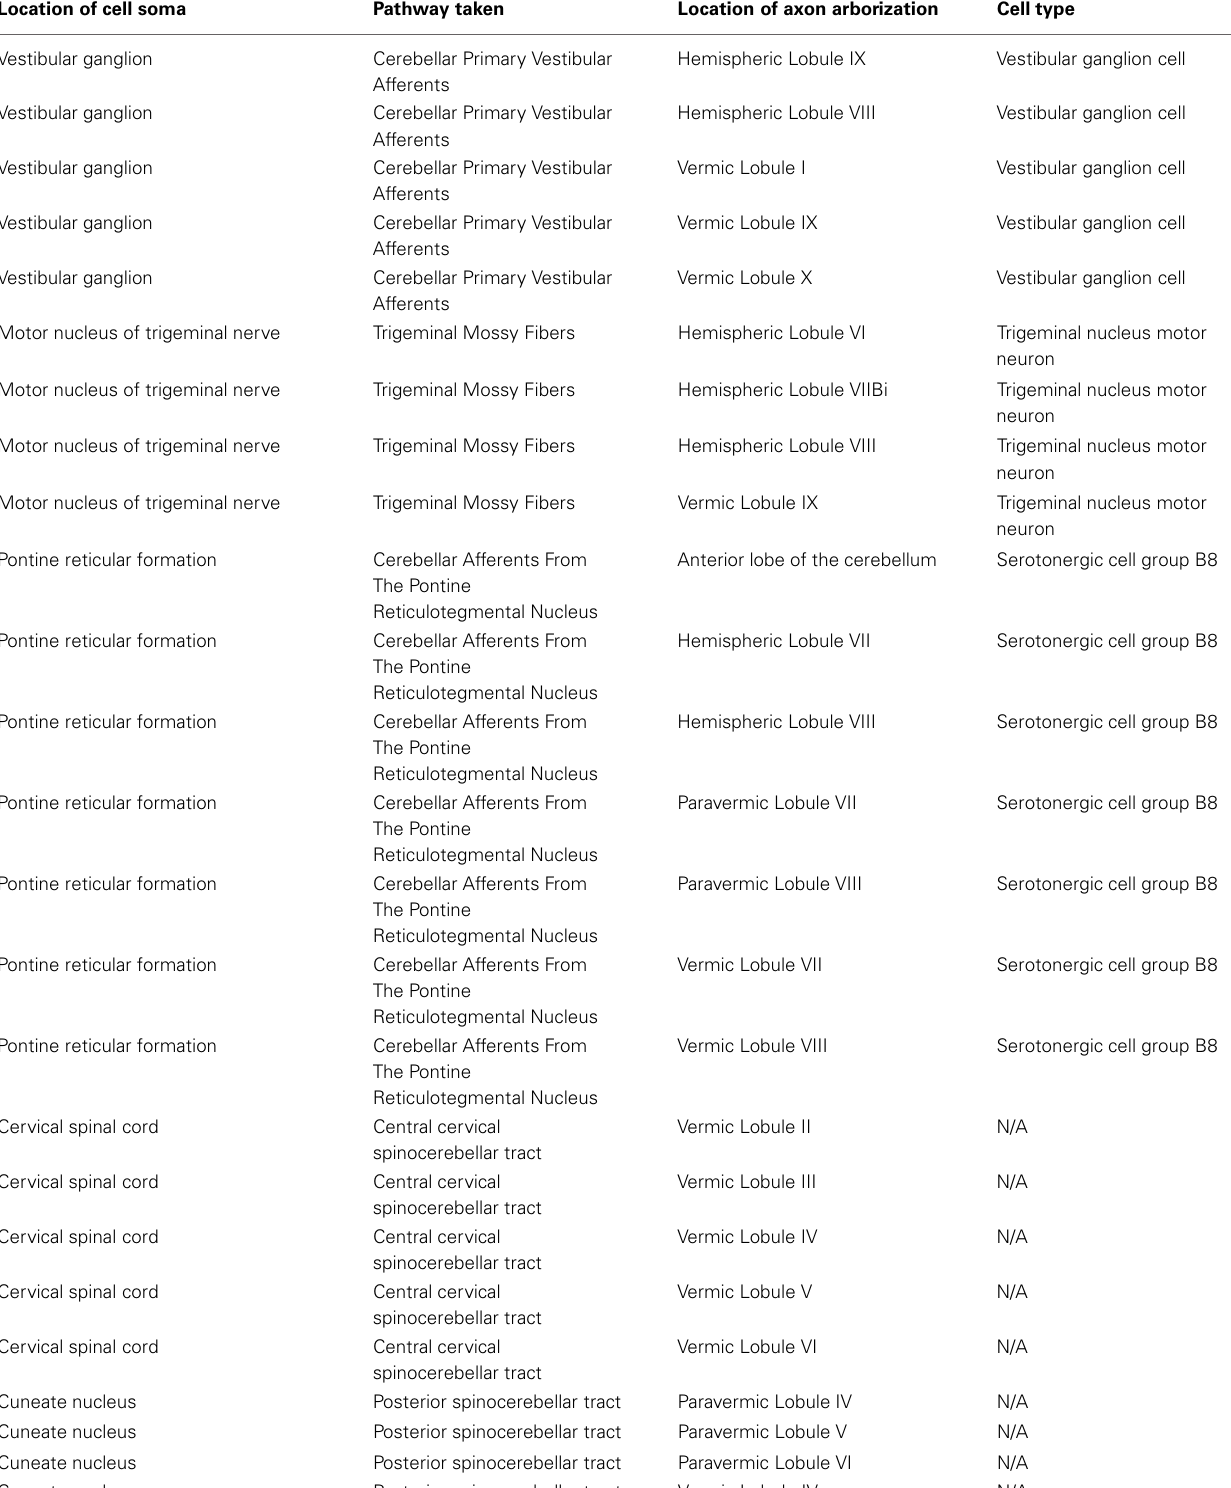
Table 4 | Results from performing the query in Table 3 to answer the question what brain regions project to some part of the cerebellum. Location of cell